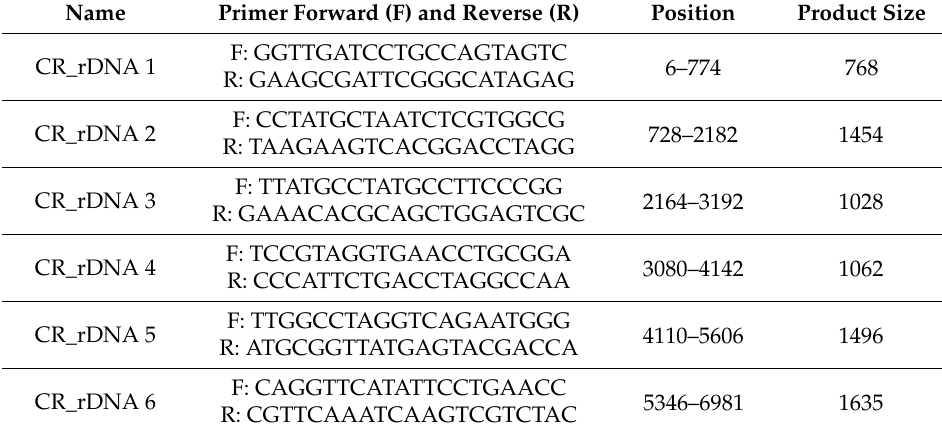
Table 1. List of primer sequences used for cloning and sequencing the rDNA of target region of P. brassicae (see Figure